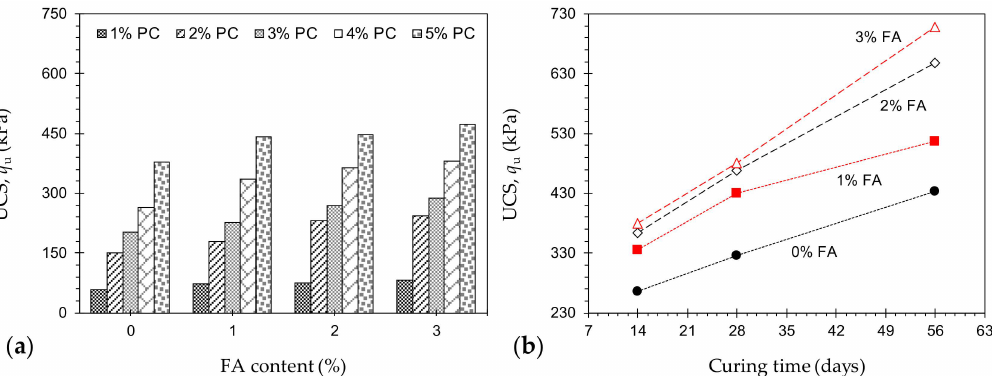
Figure 2. ( a ) Variations of UCS against FA content for various mix designs tested at 14 days of curing— P a F b T 14 where a = {1, 2, 3, 4, 5}, and b = {0, 1, 2, 3}; and ( b ) Variations of UCS against curing time for various mix designs containing 4% PC— P 4 F b T c where b = {0, 1, 2, 3}, and c = {14, 28, 56}.